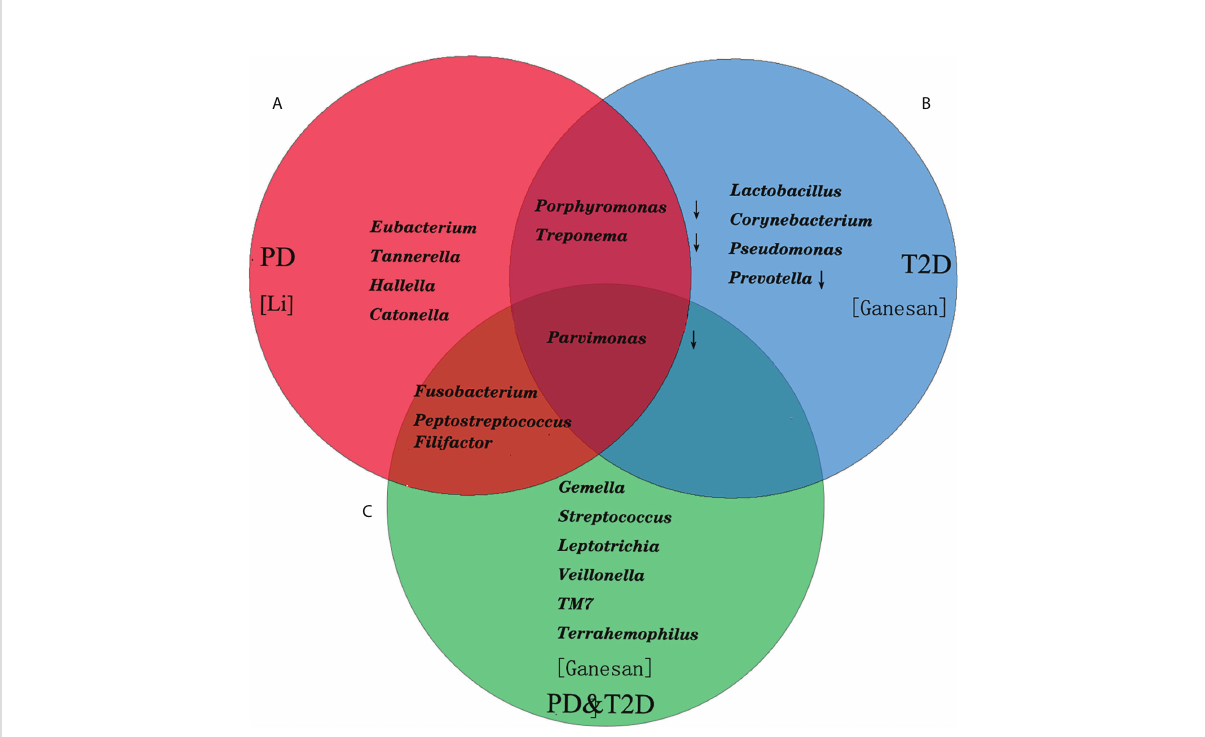
FIGURE 1 The composition of the top 10 bacterial genera in relative abundance in patients with periodontitis and T2D. (A) The Tannerella , Catonella , Eubacterium , Parvimonas , Hallella and so on were closely related to periodontitis. (B) The Lactobacillus , Corynebacterium , Pseudomonas in T2D increased signi fi cantly. (C) The Fusobacterium , Peptostreptococcus , Filifactor shared with PD, and Parvimonas shared with PD and